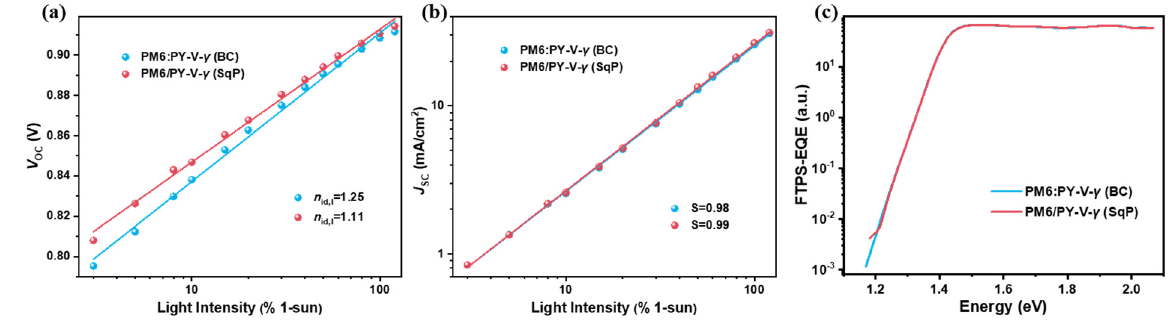
Figure 3. ( a ) J SC versus light intensity; ( b ) V OC versus light intensity; ( c ) FTPS-EQE spectra.